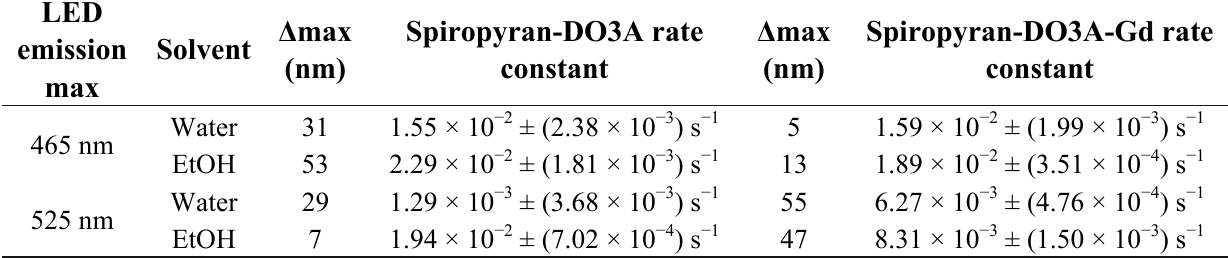
Table 1. Illumination with two LEDs: Spiropyran-DO3A and spiropyran-DO3A-Gd were illuminated with green LED possessing maximum emission at λ = 525 nm and the blue LED ( λ = 465 nm). The illumination power was equally adjusted to a total photon flux of 5.78 × 10 14 photons·s − 1 . * The column Δ max [nm] refers to the separation between the absorption peak of the CA in relation to the maximum emission peak of the